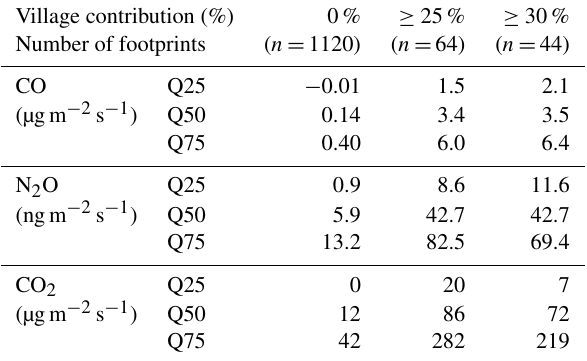
Table 1. Emission density of the natural landscape (0% village coverage) and that of the village calculated at ≥ 25% and ≥ 30% footprint-weighted coverage of the village, respectively. n gives the number of footprints available for the calculations. Q25, Q50, and Q75 indicate the lower quartile, the median, and the upper quartile of the emission densities calculated on the basis of the hourly flux values.